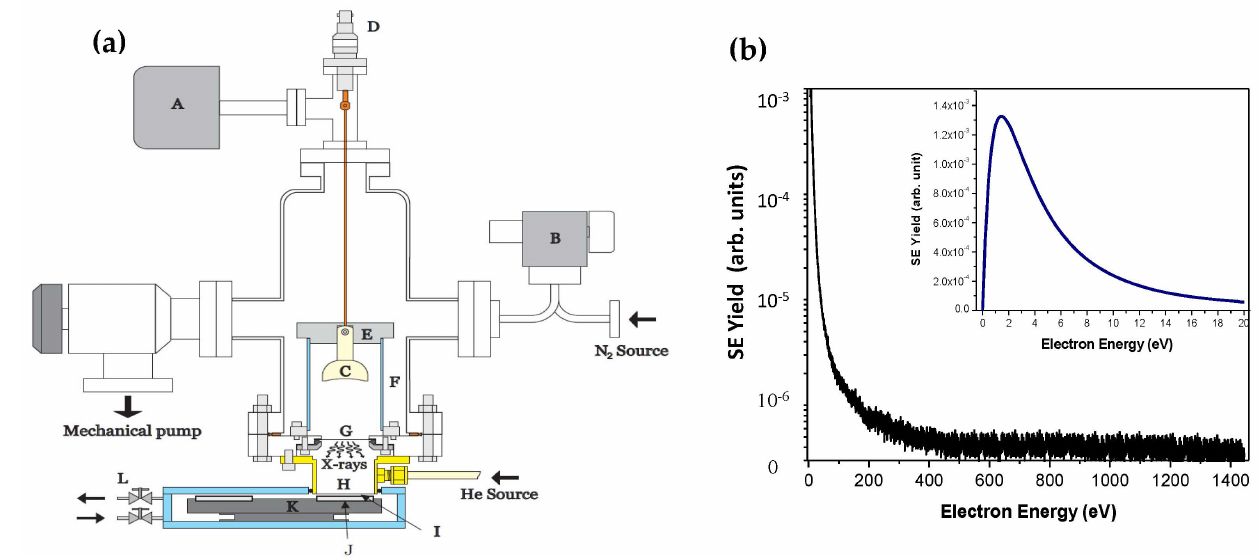
Figure 4. ( a ) Al K α X-ray source used to study LEE interactions with thin films of DNA. It is composed of a stainless-steel chamber evacuated to pressure less than 0.7 Pa and connected to a baratron (A) and an adjustable leak valve (B) connected to a nitrogen gas source. A discharge is caused by applying a negative potential of 3.4 kV to a concave aluminum cathode (C) through a high-voltage feedthrough (D). To prevent discharge between the cathode and chamber walls, the former is fixed in a glass-ceramic support (E) placed as a cap on a long quartz tube (F). Instead, a plasma discharge with 5–7 mA current is formed between the cathode and an aluminum foil target (G). The current is controlled and stabilized by the nitrogen pressure which is about 2.5 Pa. Electrons from the discharge strike the thin aluminum foil, and characteristic K α X-ray photons are emitted toward the He-filled enclosed volume (H). The photons then traverse the helium gas and a thin foil of mylar (I) to enter a multiple-sample holder chamber, in which the DNA films are deposited on different substrates (J) on a rotating disc (K) to be exposed to various doses of X-rays (i.e., different exposure times) in the presence of gases or vapors introduced through valves (L). ( b ) SE energy distribution curve from a tantalum substrate peaking at 1.4 eV. (Adapted from [109] with